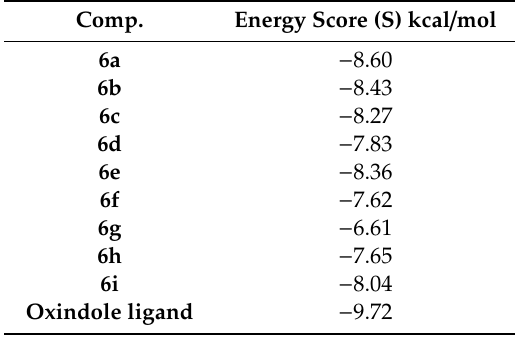
Table 7. Docking energy scores (S) in kcal / mol for the conjugates 6a–i and the added oxindole ligand in the CDK4 binding site.